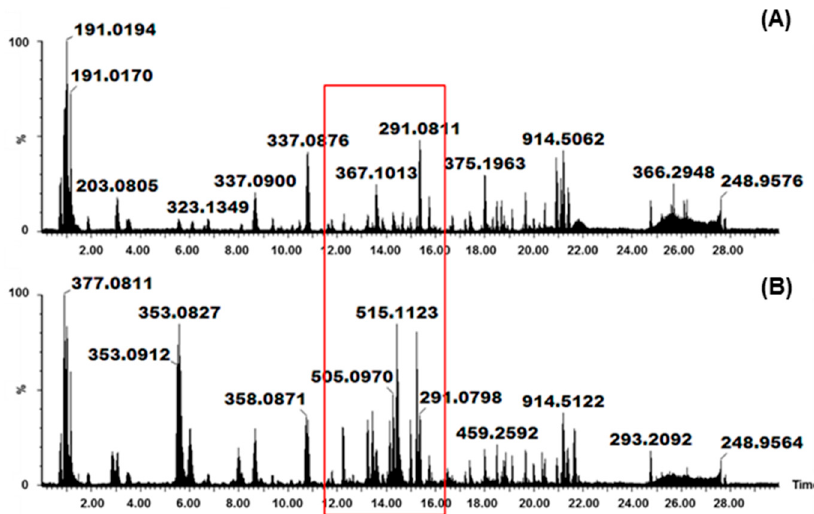
Figure 1 . Ultra-high performance liquid chromatography (UHPLC) mass chromatograms, obtained using electrospray ionization (ESI) in negative mode, representing pressurized hot water extraction (PHWE) of Vernonia fastigiata metabolites at: ( A ) 50 °C; and ( B ) 200 °C.